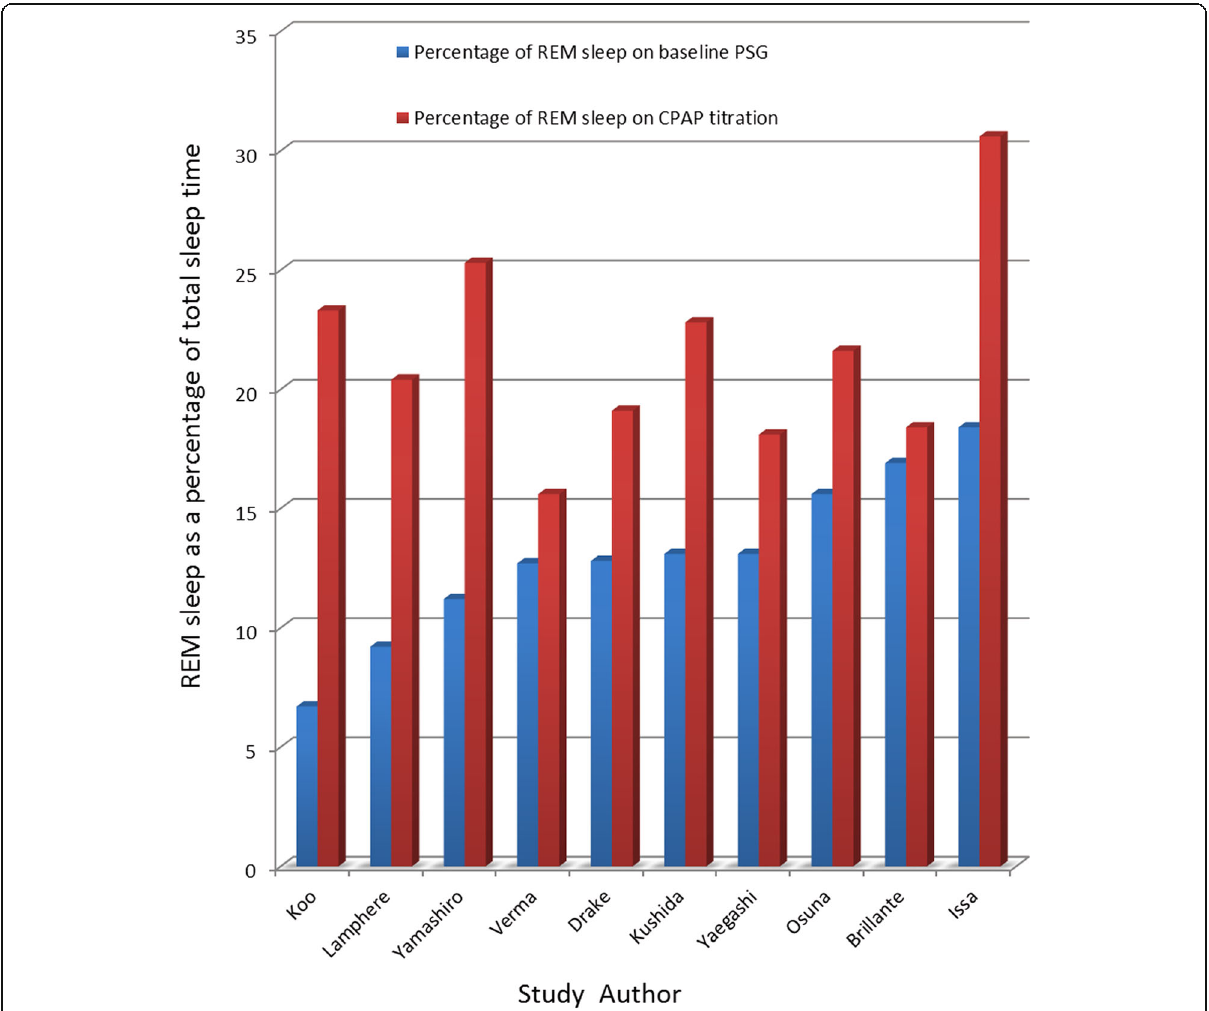
Fig. 2 Bar graph comparing mean percentage of REM sleep attained on baseline PSG vs titration PSG for studies reporting a statistically significant increase in REM